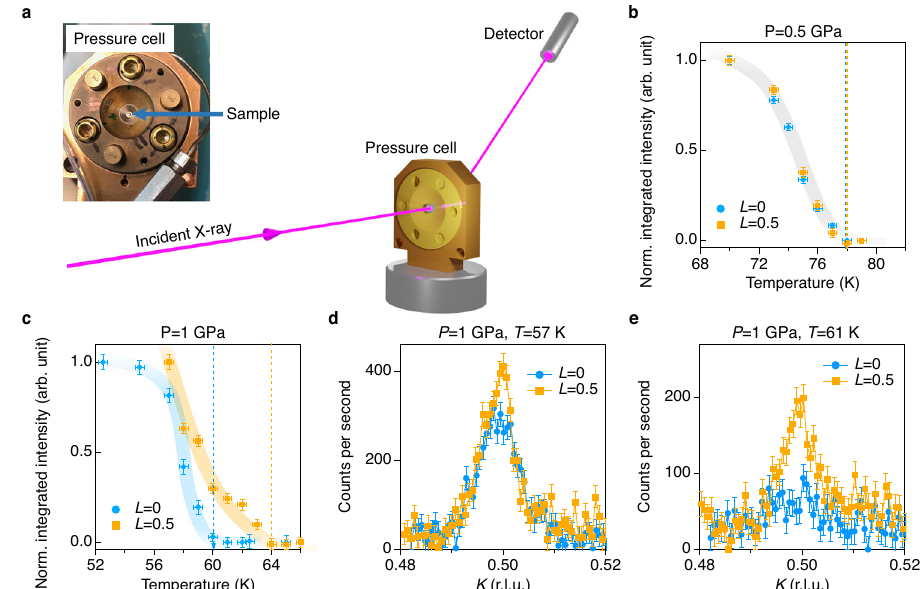
Fig. 3 | Evolution of conjoined CDWs under pressure. a The experimental geo- metryof high-pressureX-raydiffraction. b , c Normalizedintegrated CDWintensity vs temperature taken at Q 2×2×2 CDW =(3, 0.5, 0.5) and Q 2×2×1 CDW =(3, 0.5, 0) at P =0.5GPa and 1GPa. Dashed lines mark the onset temperature of the 2×2×2 CDW (yellow) and 2×2×1 CDW (blue) . The intensity in b and c is normalized by the intensity at the lowest temperature in each curve. The high-pressure X-ray scattering were taken at 20keV in a transmission geometry. The shadings in b and c are guides to the eye. d , e Direct comparison of the CDW peak intensity of Q 2×2×2 CDW = (3, 0.5, 0.5)